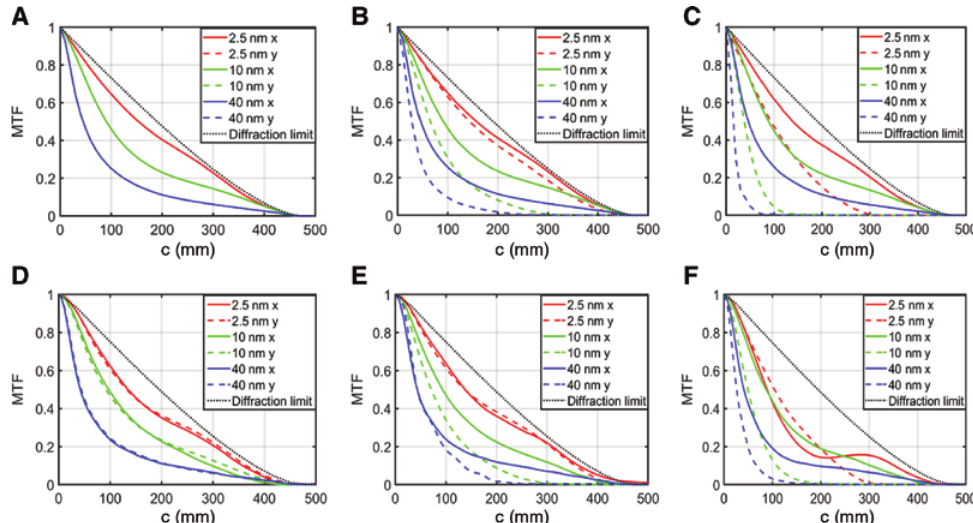
Figure 4: Polychromatic MTF measured vs. simulated results. (A, B, and C) Simulated results for on-axis, 0.4-mm off-axis, and 0.8-mm off-axis (in the image plane), respectively. (D, E, and F) Corresponding measured results. In each graph, results for three spectral widths (2.5, 10, and 40 nm) are presented and compared to the theoretical diffraction limit. The y -axis is the tangential direction (the direction in which we went